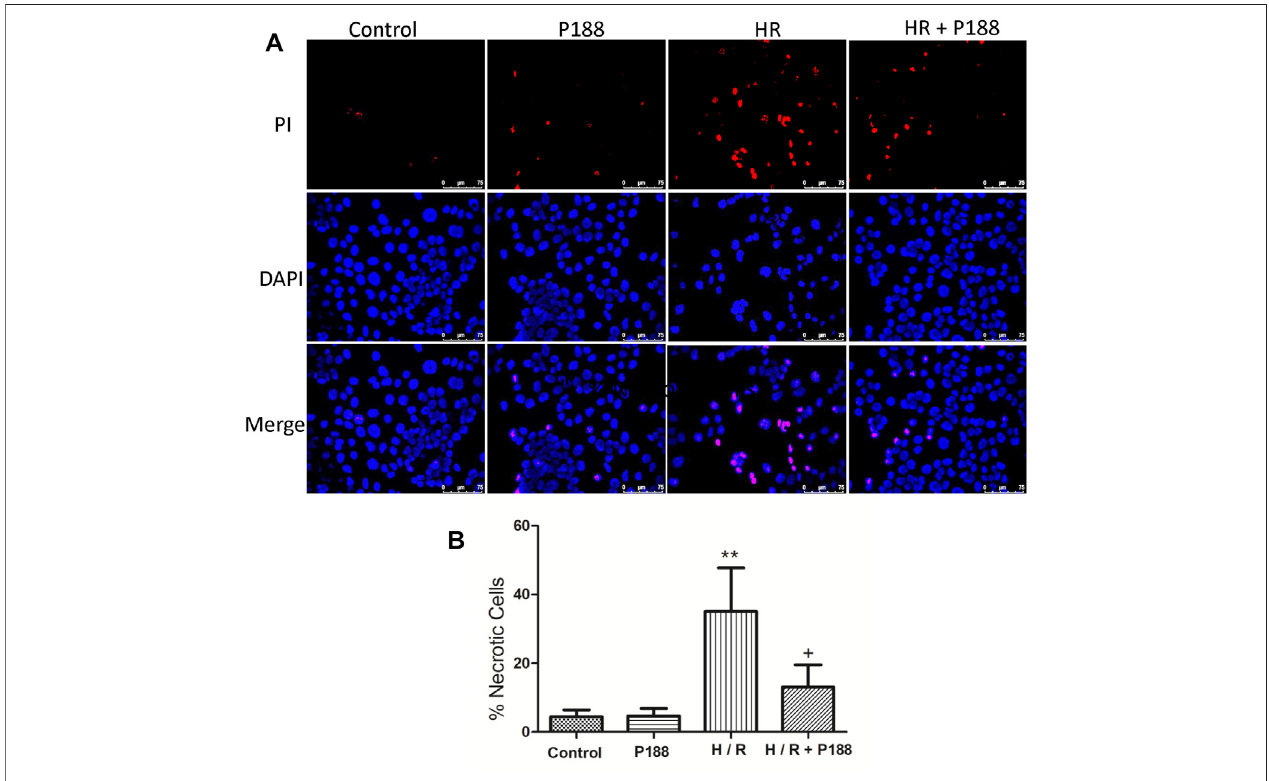
FIGURE 8 | P188 protects against hypoxia/reoxygenation (HR)-induced MLE-12 cell death. (A) Representative fl uorescence images of MLE-12 cells stained with propidium iodide (red color) and counterstained with DAPI (blue color). (B) Percentage of necrotic cells exposed to HR. Data are mean ± SD ( n (cid:2) 6 experiments under each condition). ** p < 0.01 compared with the control group; # p < 0.05 compared with the HR